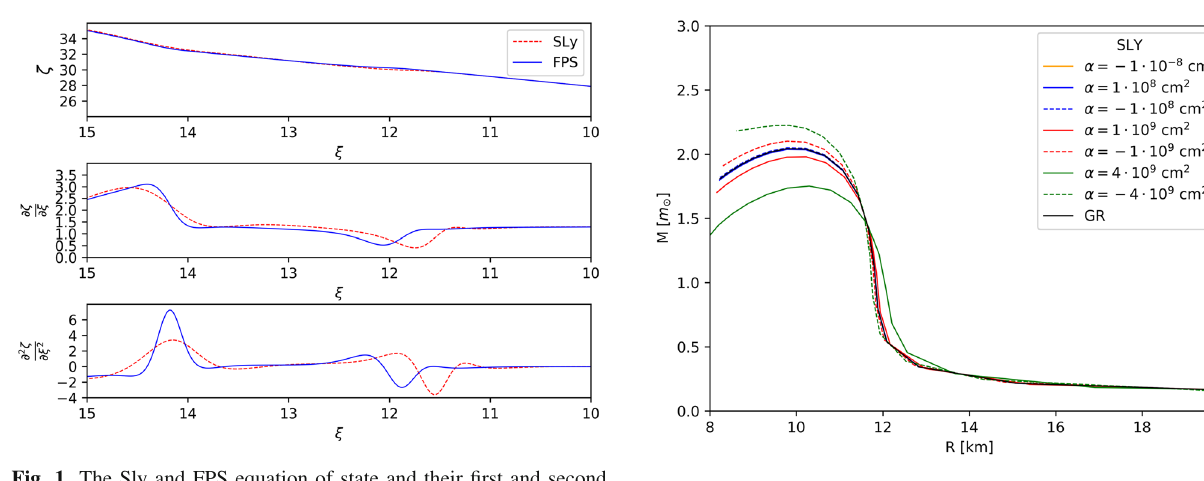
Fig. 1 The Sly and FPS equation of state and their first and second derivatives